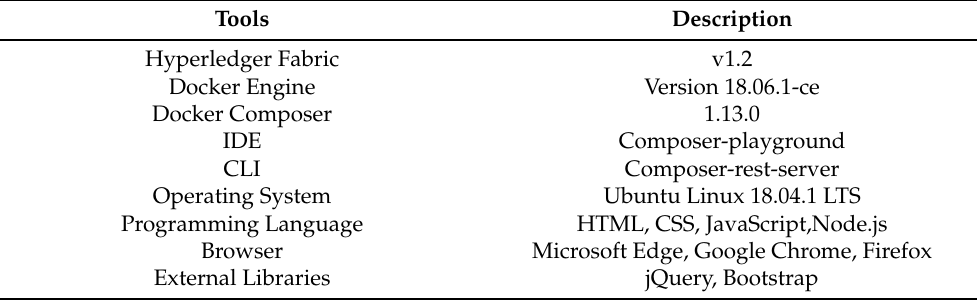
Table 1. Development Environment.